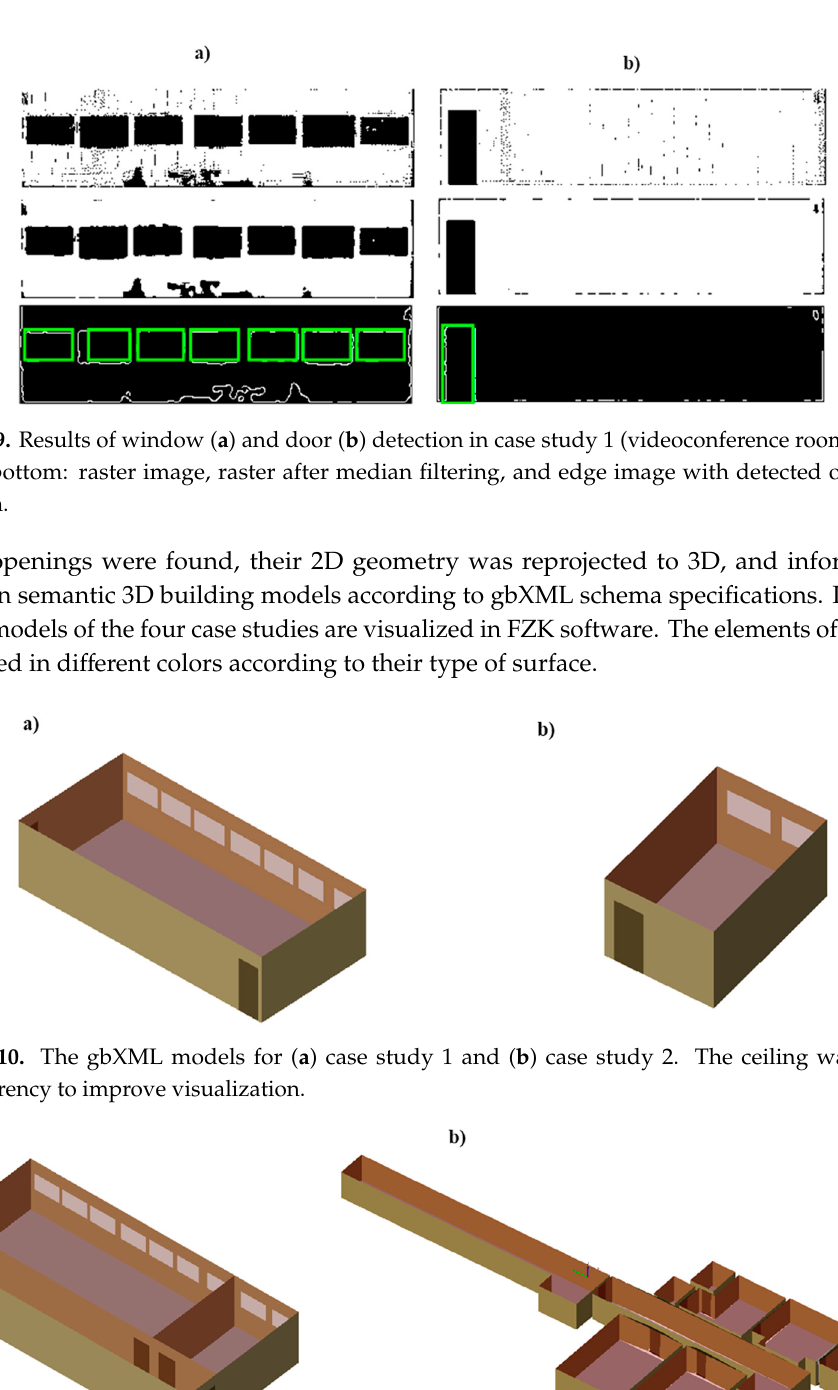
Figure 11. The gbXML models for ( a ) case study 3 and ( b ) case study 4. The ceiling was given transparency to improve visualization.